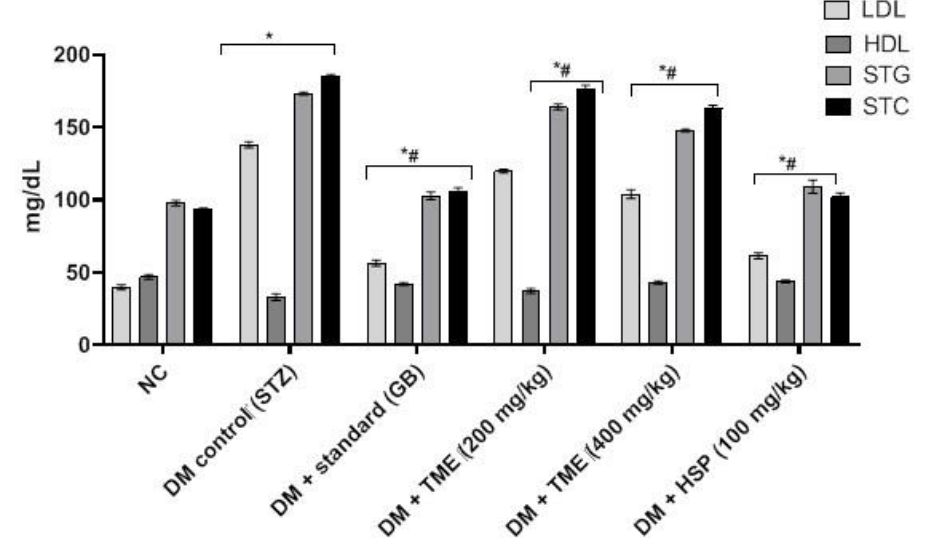
Figure 4. Lipid profile of HFD-fed STZ-induced diabetic rats treated with TME (200 and 400 mg/kg) or HSP (100 mg/kg). Values are represented as mean ± SD ( n = 6); * significant difference between control group and all other treatment groups; # significant difference between diabetic nontreated group and all treatment groups (TME and HSP). NC, normal control; TME, total methanol extract; HSP, hesperidin; STZ, streptozotocin; GB, glibenclamide; DM, diabetes mellitus; STC, serum total